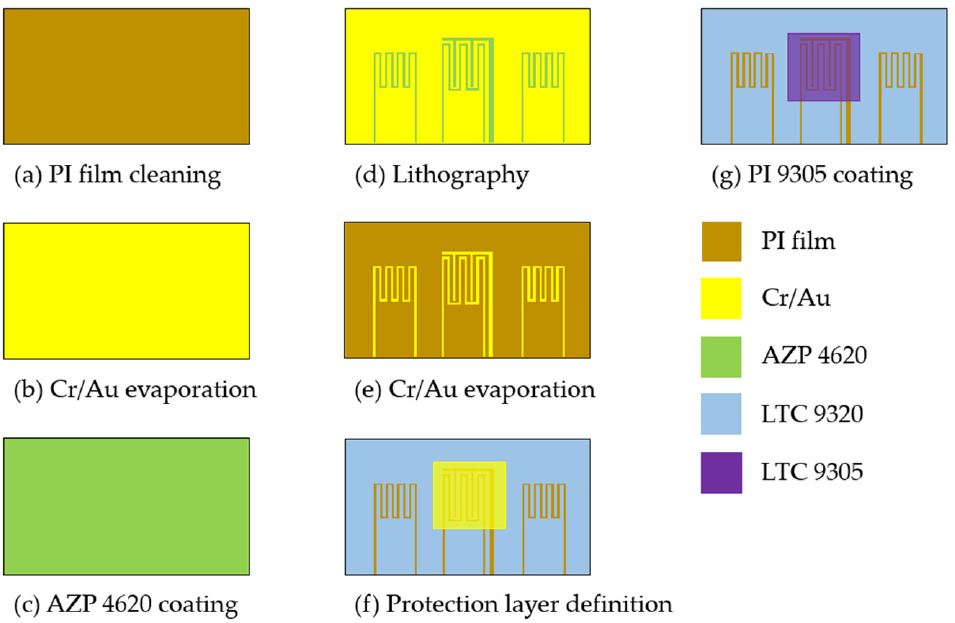
Figure 1. Fabrication process diagram of the flexible three-in-one microsensor: ( a ) is soaking PI film in Acetone, Methanol and DI water to clean, ( b ) is depositing Cr/Au with Electron beam evaporation, ( c ) is coating AZP 4620 with spin coater, ( d ) is exposure to define pattern, ( e ) is depositing Cr/Au on sensor, ( f ) is defining protection layer, ( g ) is coating PI 9305 with spin coater.